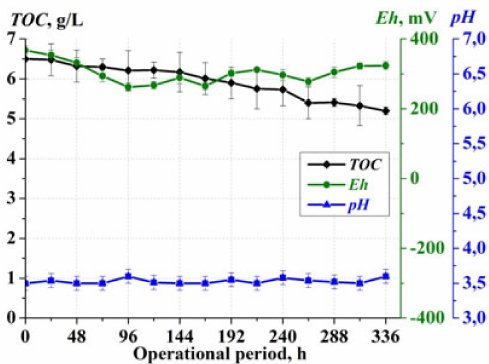
Figure 5. The inhibition of fermentation of liquid food wastes (LFW) in the absence of the granular microbial preparation and pH regulation.